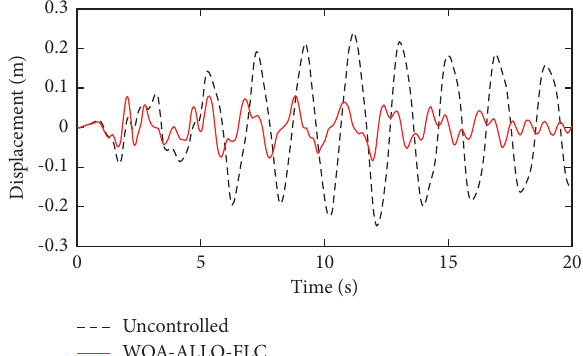
Figure 11: The top floor displacement responses of Building